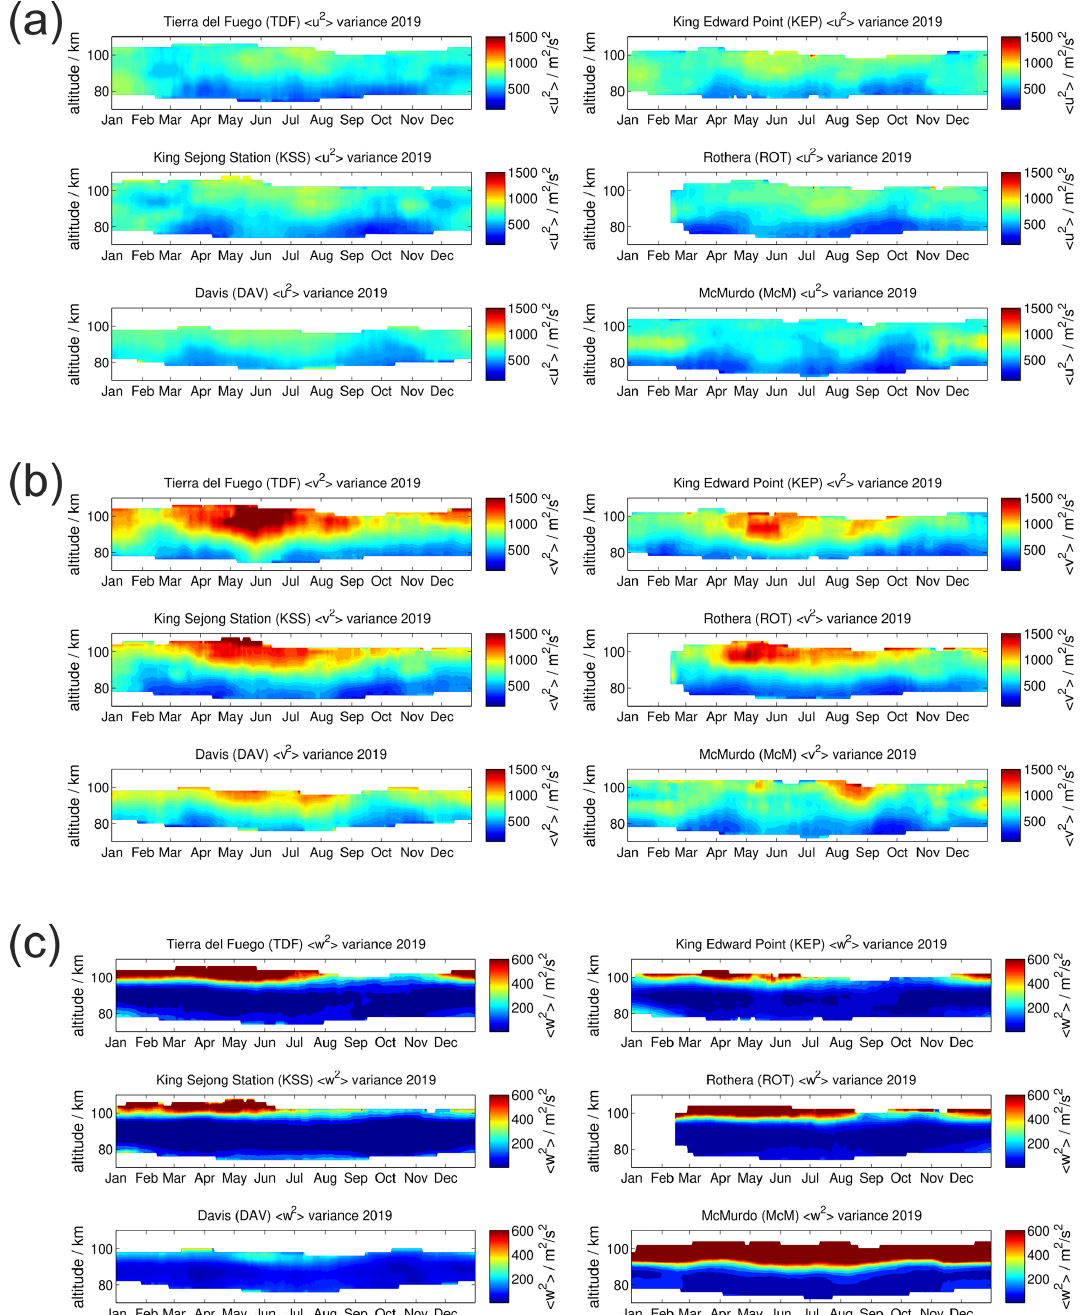
Figure 9. Same as Fig. 8 but for the (a) zonal, (b) meridional, and (c) vertical wind